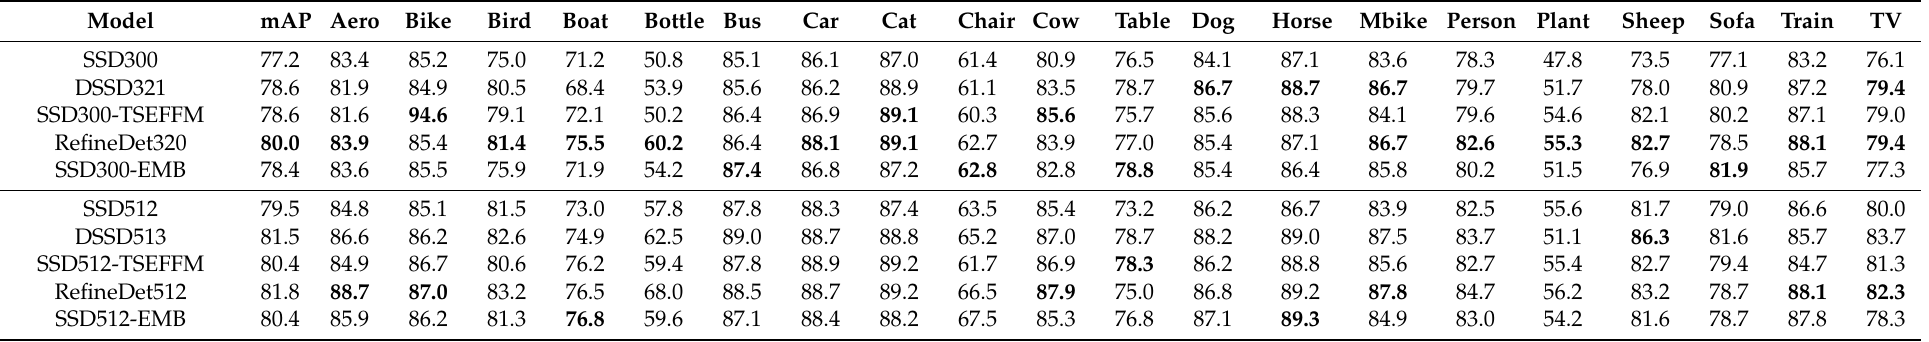
Table Dog Horse Mbike Person Plant Sheep Sofa Train